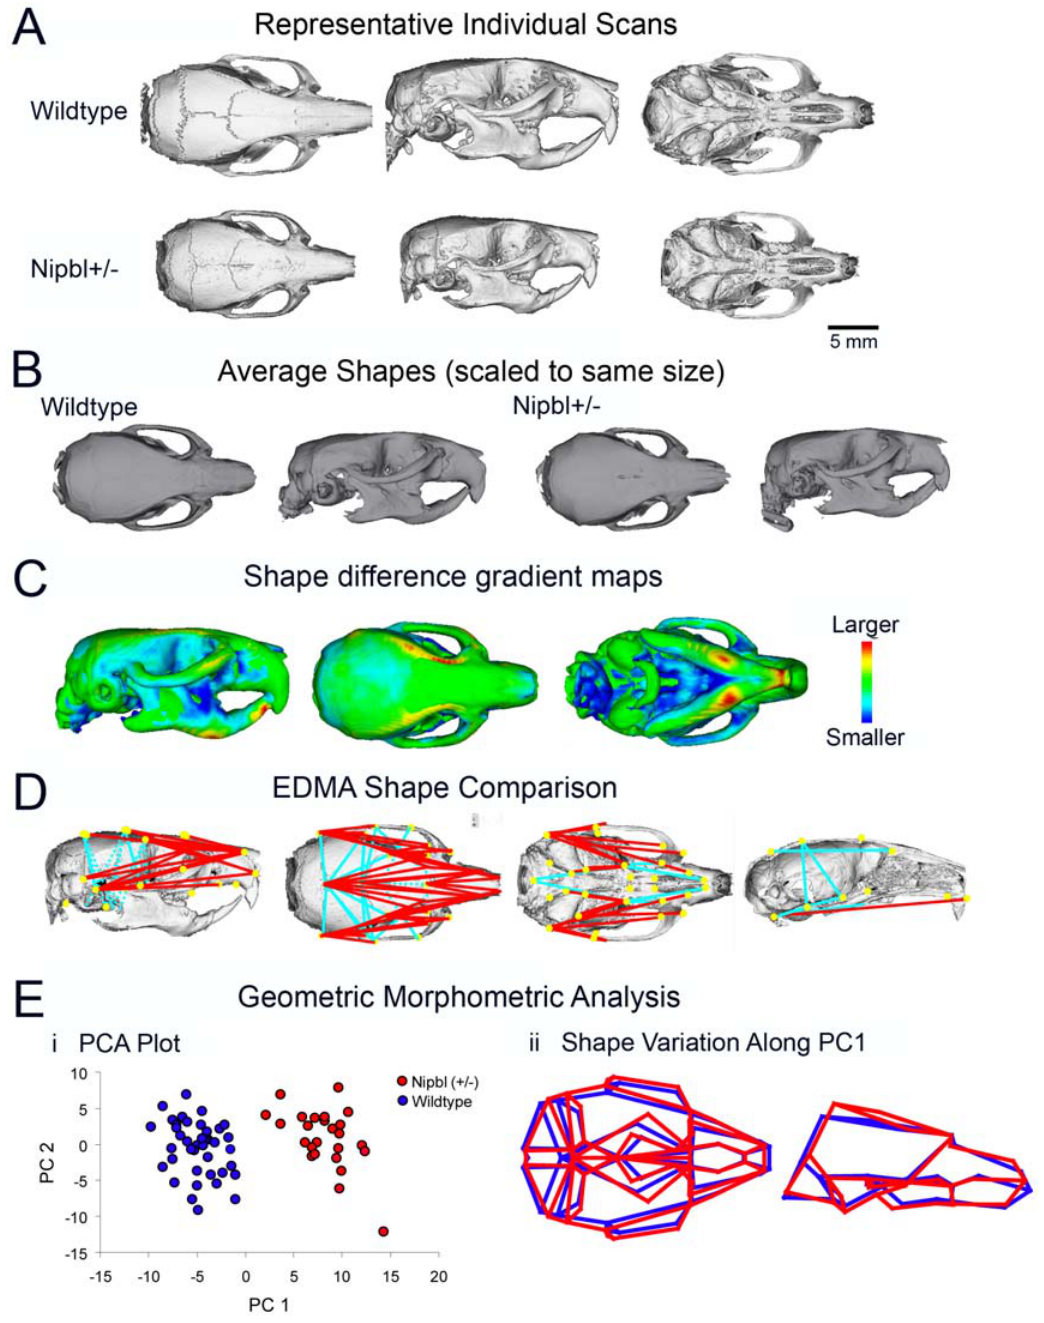
Figure 3. Craniofacial alterations. Morphometric analysis of craniofacial morphology was based on micro-CT scans of 23 mutant and 40 wildtype mice (N 0 and N 1 generation; mixed sexes, ages 218–373 days). (A) Representative reconstructions of wildtype and mutant skulls. From left to right, dorsal, lateral, and ventral views are shown. (B) Average shapes for both genotypes, obtained as described by [131], using the entire sample of scans. (C) Shape distance map [131], showing the distribution of shape effects of the mutation. (D) Results of Euclidean Distance Matrix Shape analysis. This analysis compares the entire set of linear distances between landmarks to identify local differences in form. The two groups are significantly different in shape by a Monte Carlo randomization test (p , 0.001). Distances shown are those that differ . 5% between groups. Red lines are distances that are relatively smaller in the mutant; blue lines are those that are relatively larger. (E) Results of geometric morphometric analysis (Procrustes superimposed) of craniofacial shape. In this form of analysis, the 3D landmarks representing each individual are scaled to remove size and then superimposed using a translation and rotation step. This yields a dataset in which the differences in landmark position reflect differences in shape independently of size. (i) Principal components analysis can be used to visualize the variation in such a dataset, by transforming a set of correlated variables into a new set of uncorrelated ones, each representing successively smaller portions of the total sample variance. (ii) Variation along a principal component can be represented as a deformation of a wireframe drawn using the landmarks. The first principal component (PC1) distinguishes mutants from wildtypes. The two groups are also significantly different in shape by Goodall’s F-test and MANOVA (p , 0.001). The first principal component for the combined sample captures the shape variation that distinguishes the groups. The left panel indicates dorsal view of the wireframe and the right indicates lateral view. Blue=wildtype, red= Nipbl + / 2 .